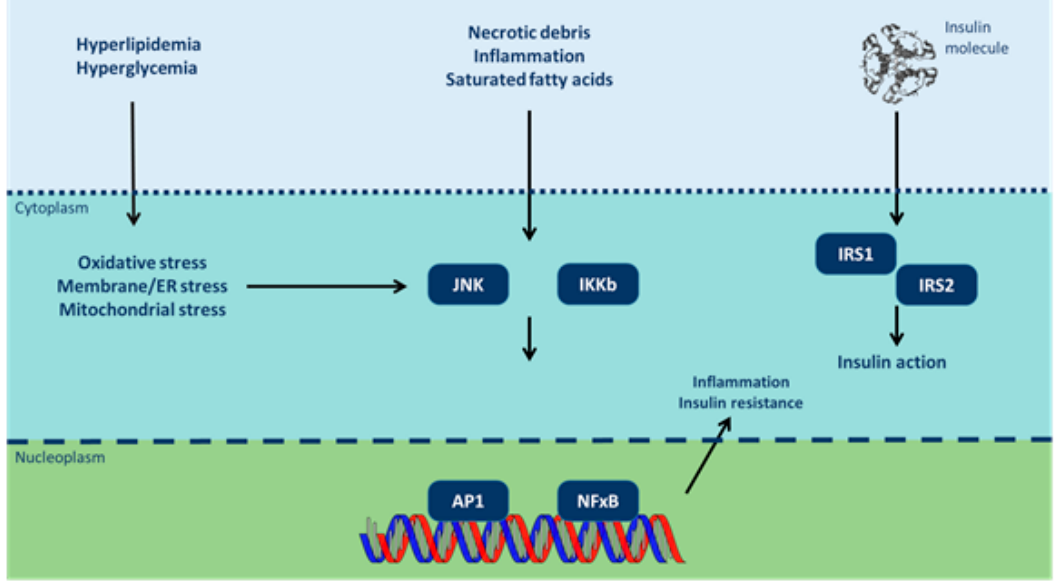
Figure 1. Inflammatory signaling pathways link nutrient excess to insulin resistance (modified from